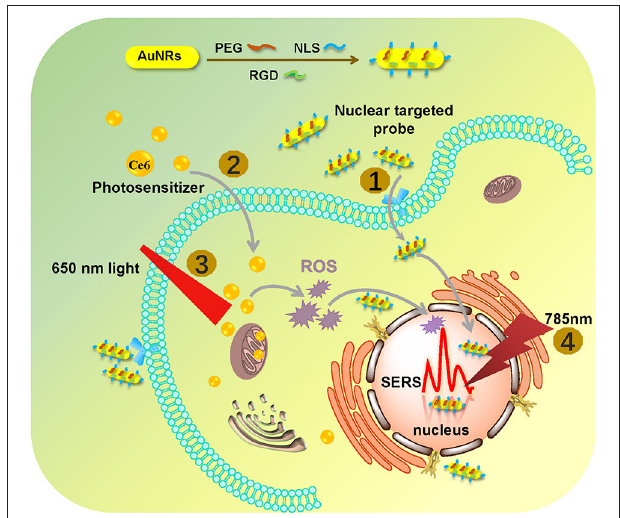
FIGURE 1 | The procedures of monitoring the changes of the nuclear signal after photodynamic therapy by SERS spectroscopy with the AuNR-based nucleus-targeted nanoprobes. À - Ã correspond to the pre-loading of the targeting nanoprobes to the cell nucleus, the internalization of PS in the cell, the irradiation of Ce6 to produce ROS, and the SERS measurement of a cell